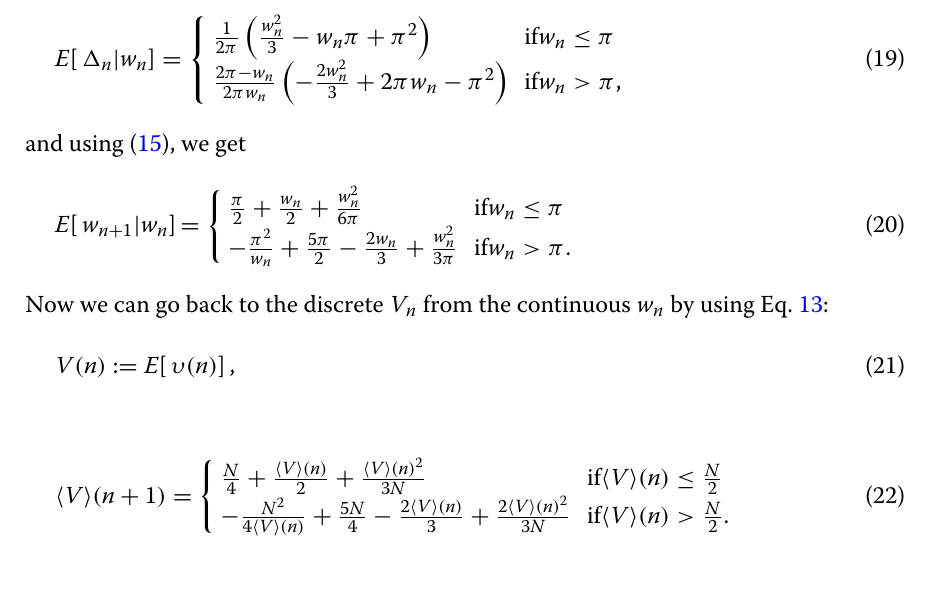
Plugging in the piecewise-linear functional form of (cid:2) n as described in Fig. 8 into Eq. (18)